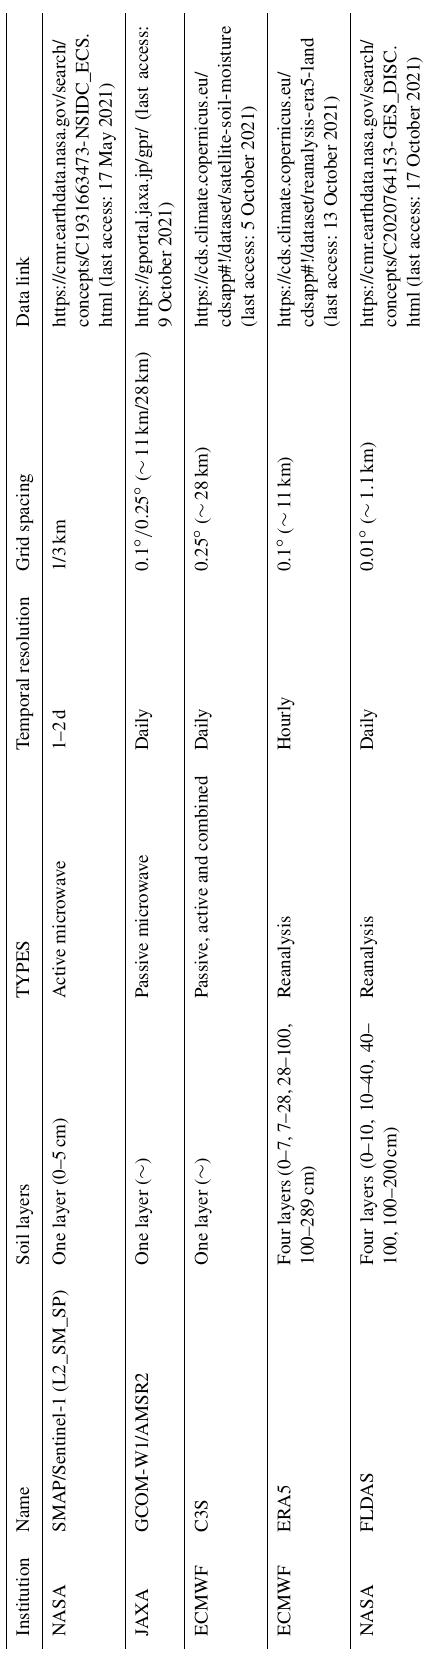
Figure 3. The number of valid samples for a 16d period in 2015– 2020. DOY is the day of year.